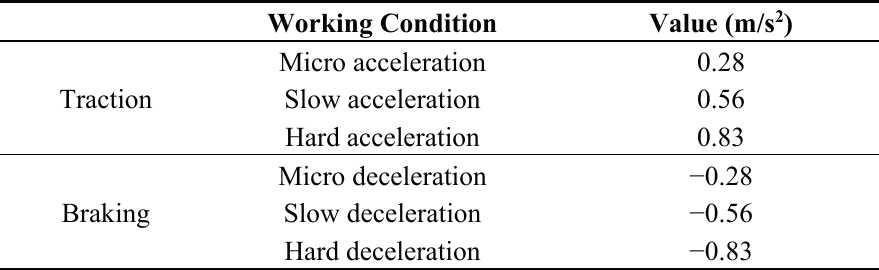
Table 2. Experimental working